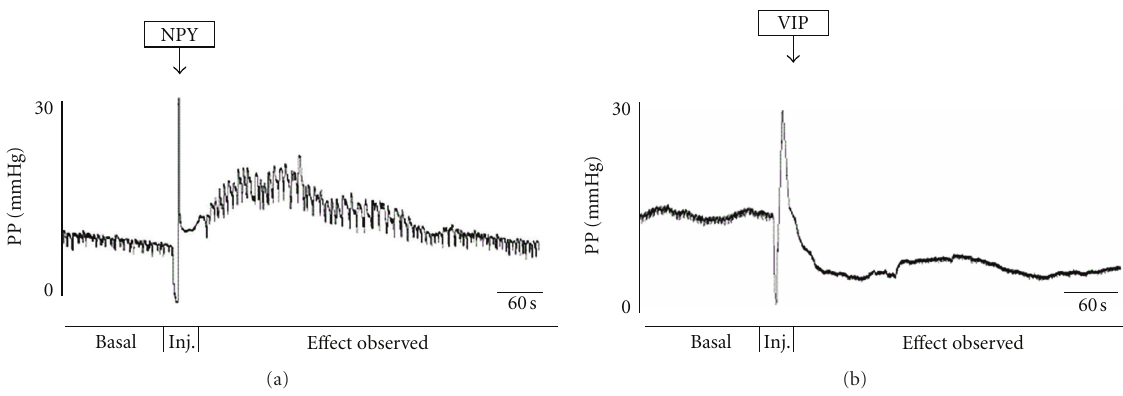
Figure 2: Example of changes in vascular tone observed after an intra-arterial injection of NPY in group A, causing vasoconstriction and increase in frequency and amplitude of the oscillations. We can see an example of an e ff ect of an intra-arterial injection of VIP in perfusion pressure, producing vasodilation and decrease in frequency and amplitude of the oscillations. On the x axis, the perfusion pressure recorded at the rabbit external ophthalmic artery is represented in mmHg. In the y axis, we represent the time in seconds.